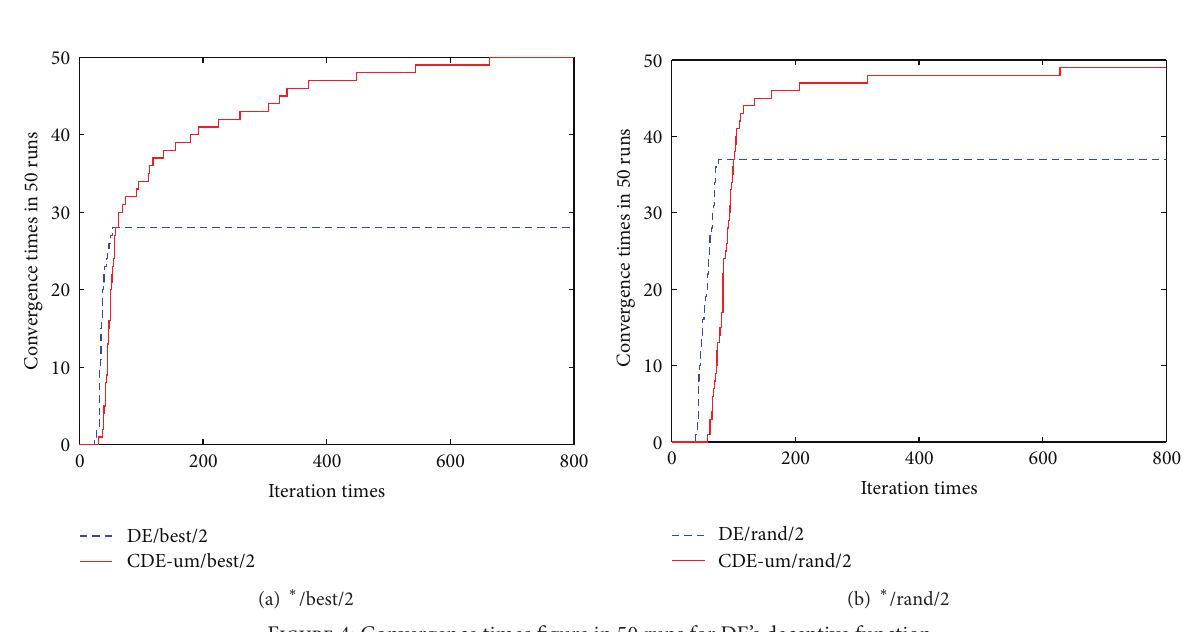
Figure 4: Convergence times figure in 50 runs for DE’s deceptive